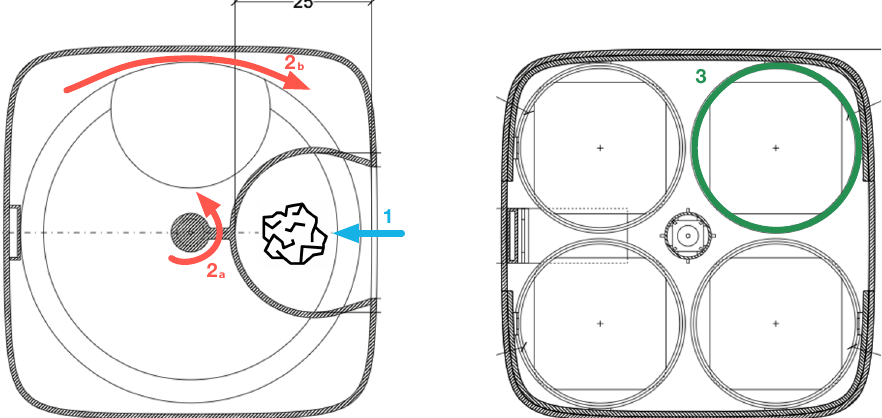
Figure 5. Waste disposal unit. (1) A piece of trash is inserted into the SWB and recognized. (2a) The semicircular structure acts as a mechanical arm and moves the trash towards the correct bin. Concur- rently (2b), the shelf moves to let the trash fall into the correct bin in the garbage unit